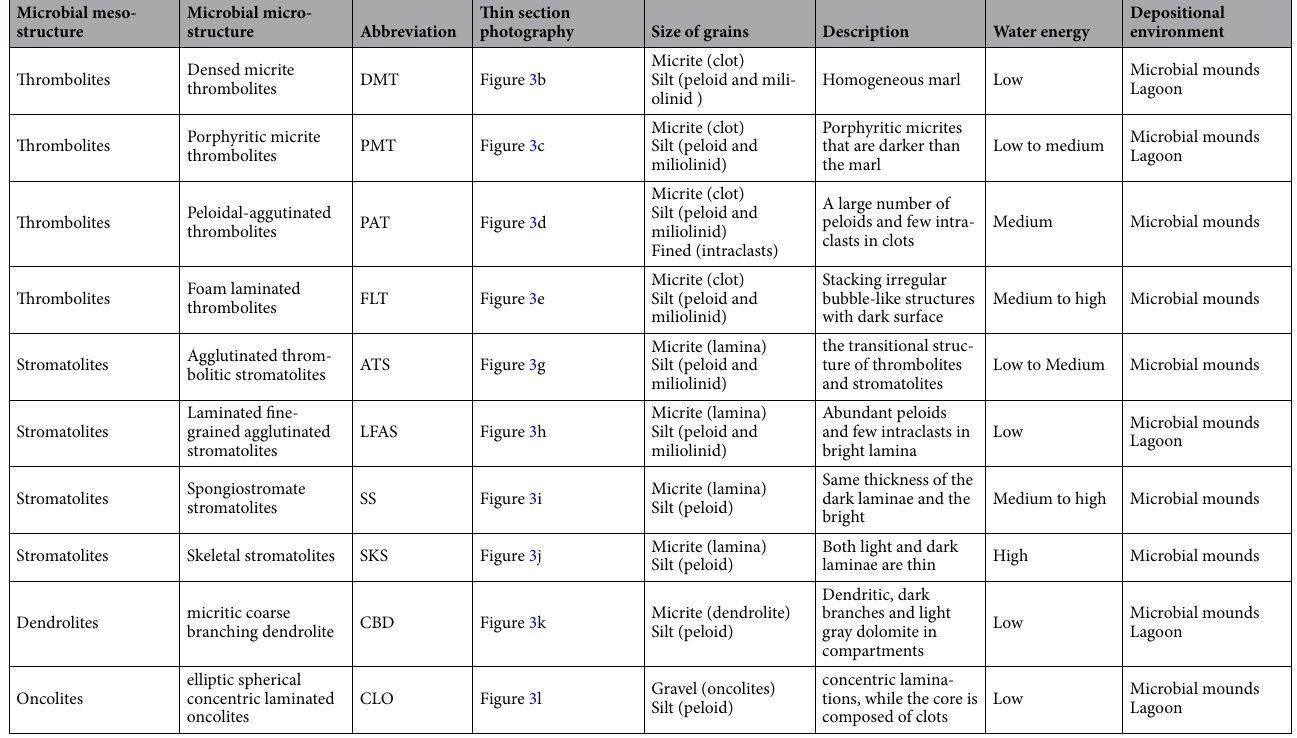
Table 1. Types of microbial carbonates in the fourth member of the Leikoupo Formation in Western Sichuan